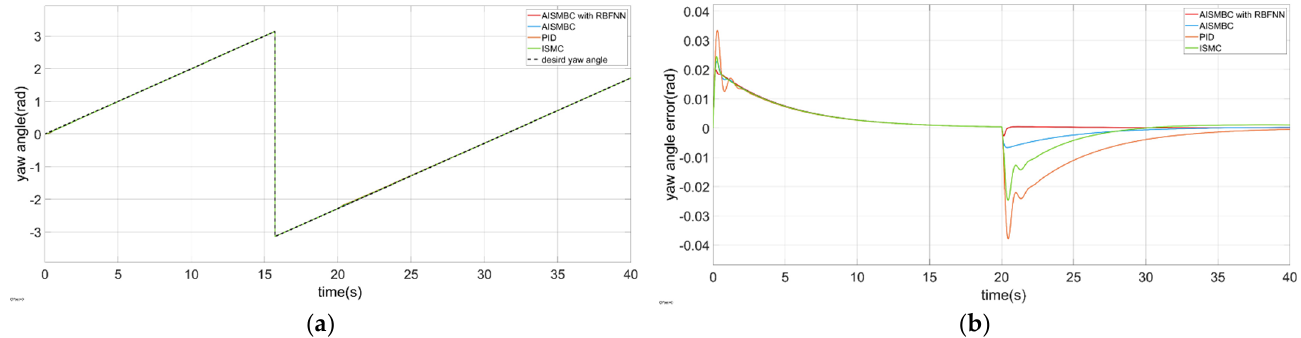
( d ) Figure 15. The results of the yaw angular velocity control with the step disturbance. ( a ) The results of the three control methods for the yaw angular velocity. ( b ) Local amplification of the yaw angu- lar velocity control results. ( c ) Adaptive gain of AISMBC. ( d ) Adaptive gain of AISMBC with RBFNN. As shown in Figure 15a, the robot could follow the desired yaw angular velocity with the three methods, but there was an overshoot in the PID control and ISMC. At 20 s, the step disturbance was applied to the yaw angle acceleration, and the PID controller (orange line) exceeded the safety boundary. The maximum tracking error of ISMBC (green line) was about 0.08 rad/s. The maximum tracking error of AISMBC (blue line) was about 0.05 rad/s. The maximum tracking error of AISMBC with RBFNN compensation (red line) was